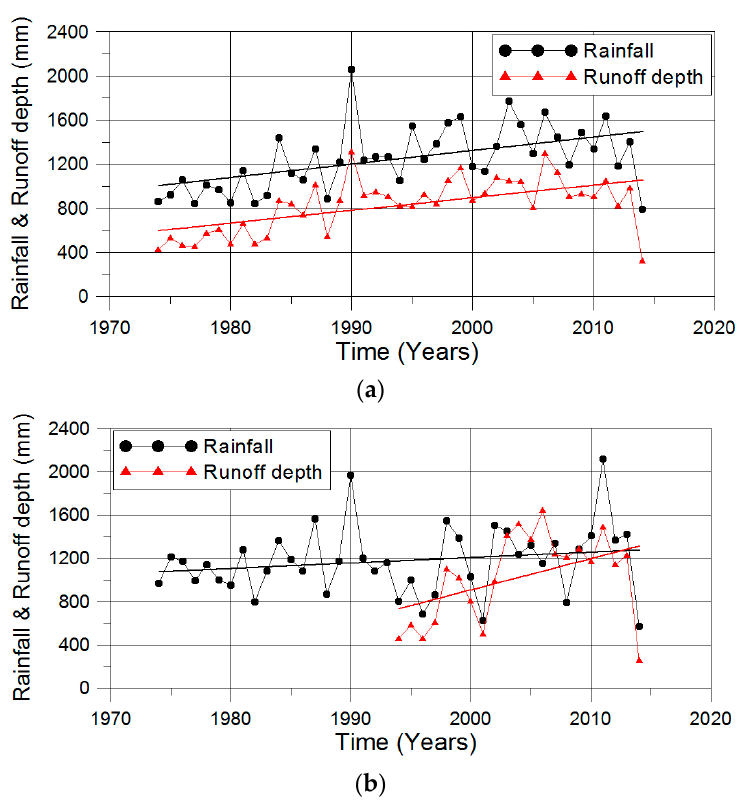
Figure 2. Rainfall and runoff depth in two basins. ( a ) Soyang Dam upper basin; ( b ) Seom River basin.